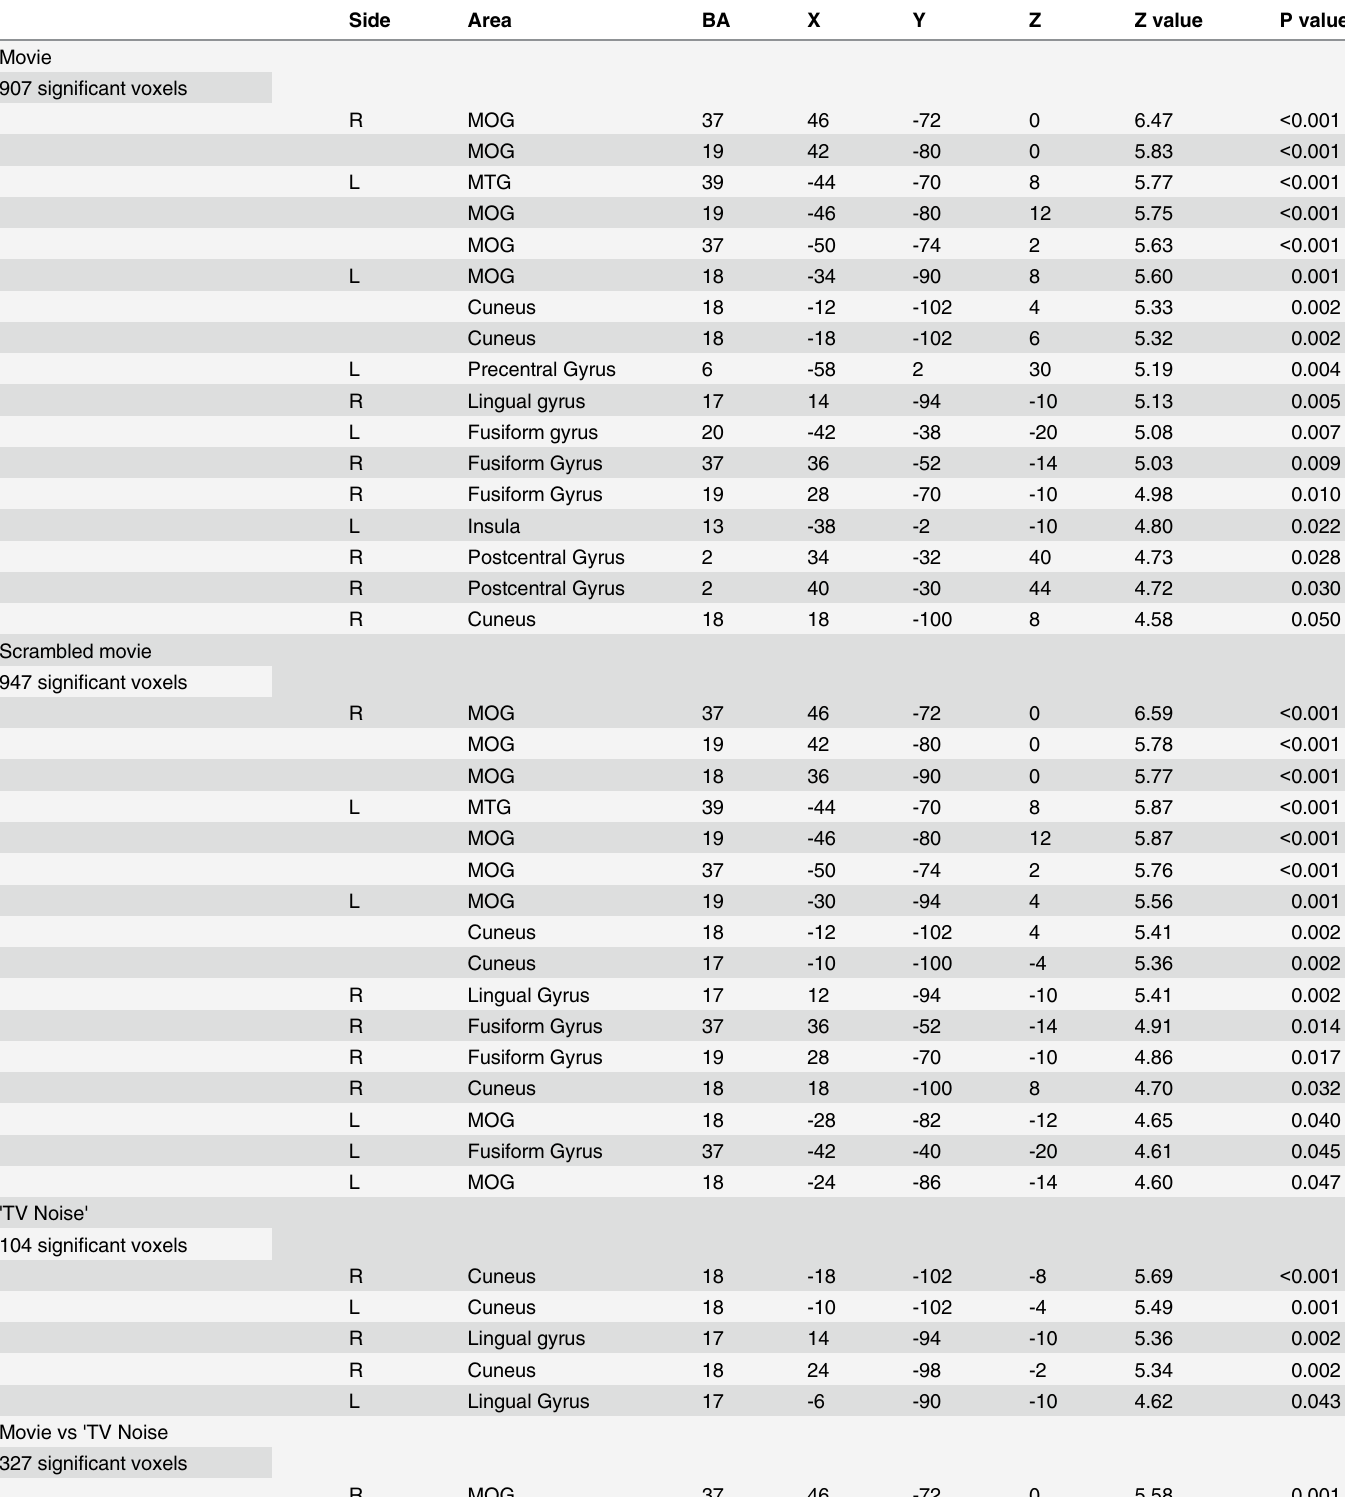
Table 1. Block design overall activation versus a black screen